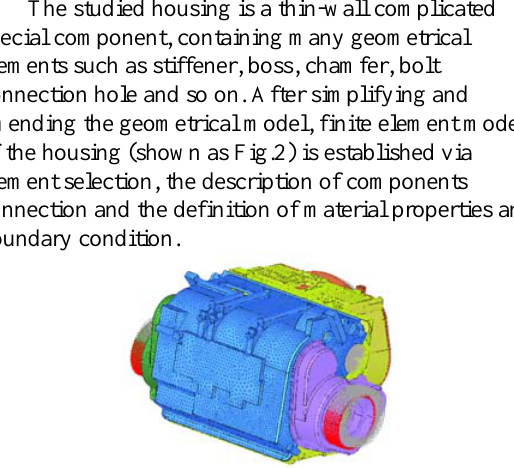
Fig.2. Finite element model of gearbox